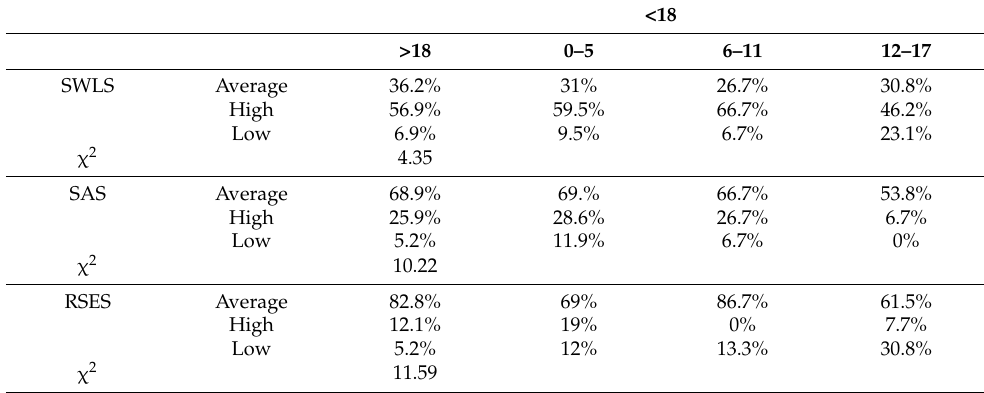
Table 5. The differences in the SWLS, SAS, and RSES levels in the subgroups of those who learnt